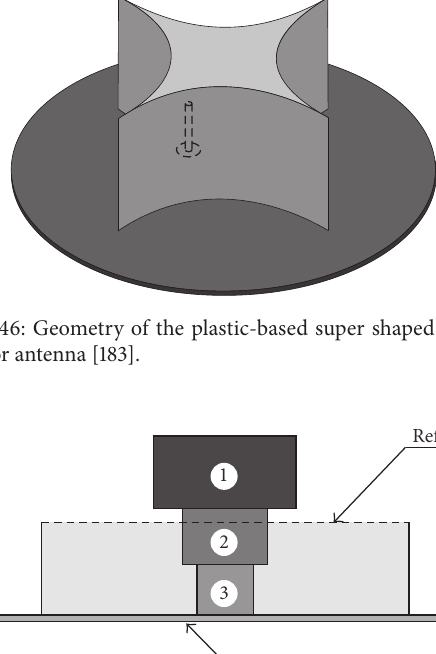
Table 5: Techniques for DRAs excitation.